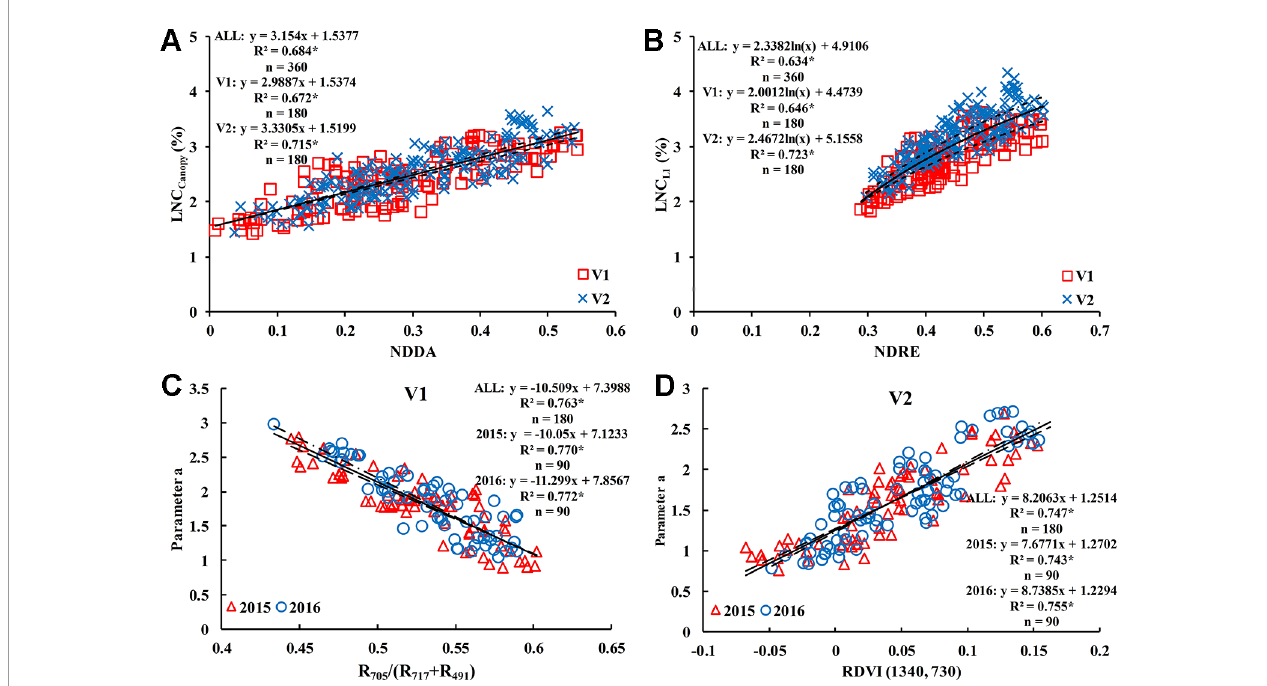
FIGURE 10 | Optimum vegetation indices for estimating LNC Canopy (A) , LNC L1 (B) , and parameter “ a ” [ (C) is V1 and (D) is V2]. * means accurate to